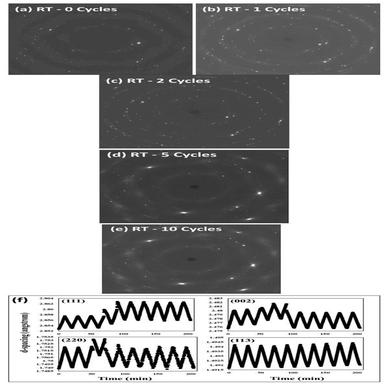
Full Debye-Scherrer diffraction rings of Pb-Bi at room temperature taken (a) before the first cycle and (b-e) after cycles 1, 2, 5, and 10. (f) Fitted peak position vs. time for the (111), (002), (220), and (113) reflections from the Pb-Bi sample over 10 thermal cycles.